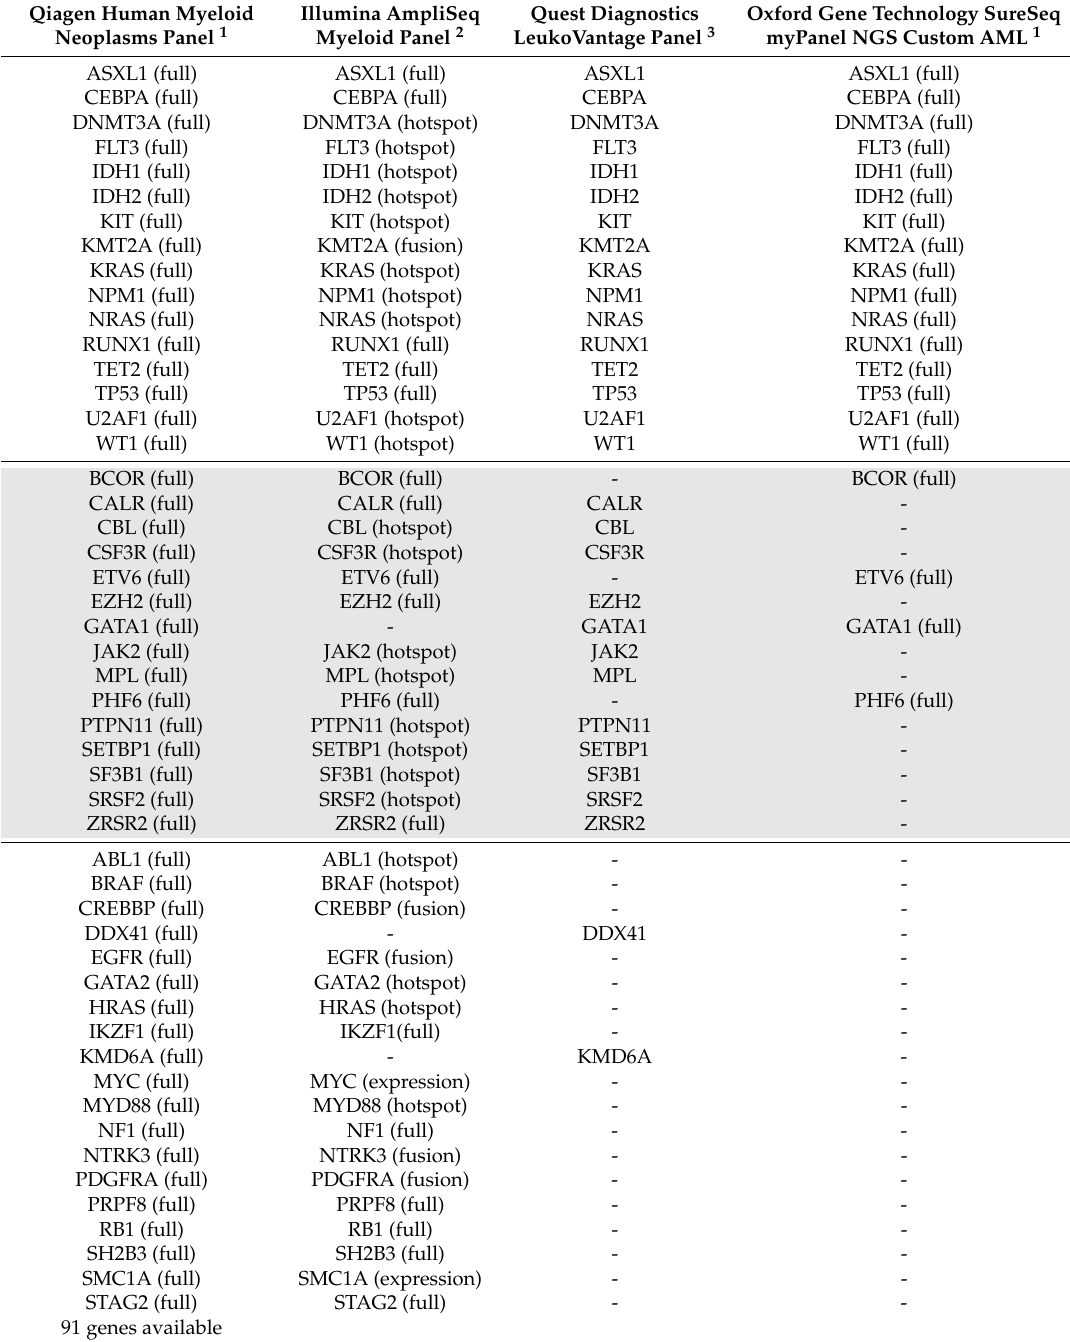
Table 1. Overview of commercially available NGS panels for AML with a list of included